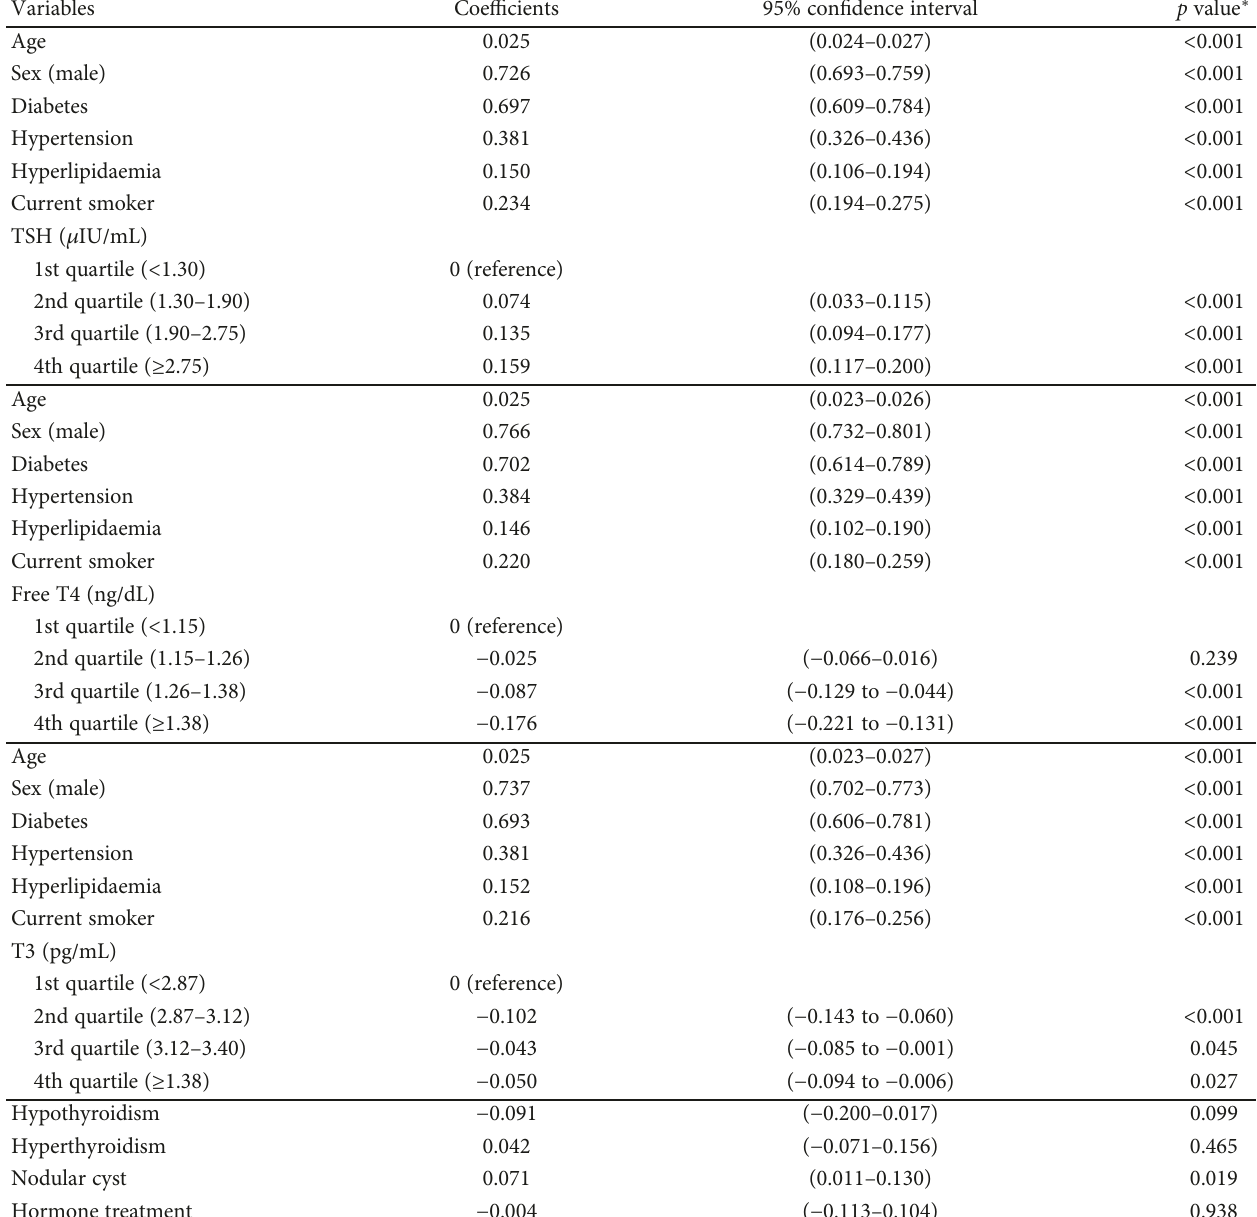
Table 5: Adjusted coe ffi cients and 95% con fi dence intervals of IOP strati fi ed by each thyroid function parameter in a normal population without